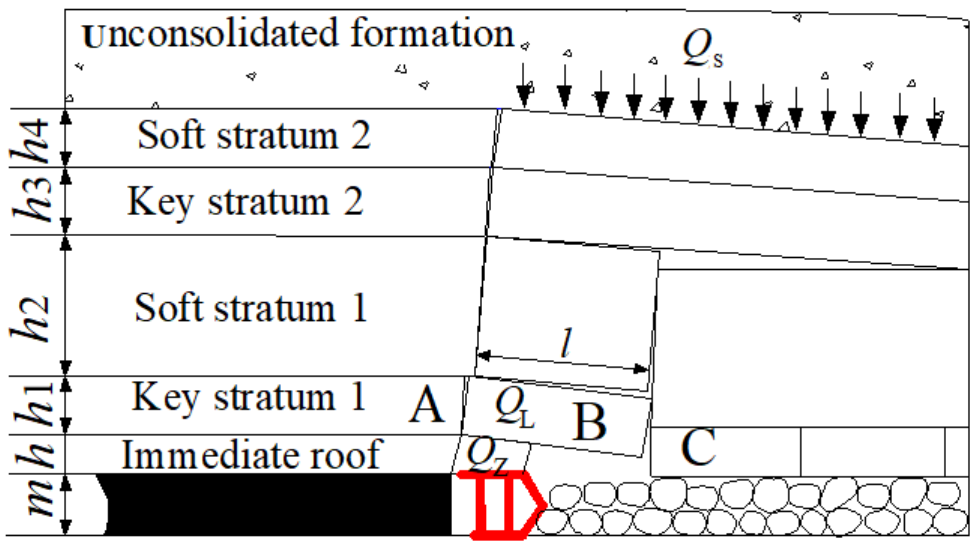
Figure 6. Relationship between support and surrounding rock in the case of two key strata.